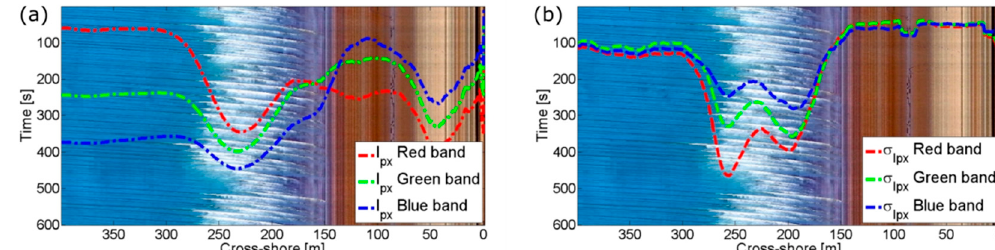
Figure 4. Timestack pixel intensity statistics, example with Timestack produced from Ribeira d’Ilhas images. ( a ) Averaged pixel intensity I px for Red (red line), Blue (blue line), and Green (green line) band of the Timestack; ( b ) standard deviation of pixel intensity σ I for Red (red line), Blue (blue line), and Green (green line) band of Timestack. Note that I px and σ I are superimposed to Timestack for description purposes and have an inverted y-axis unit.